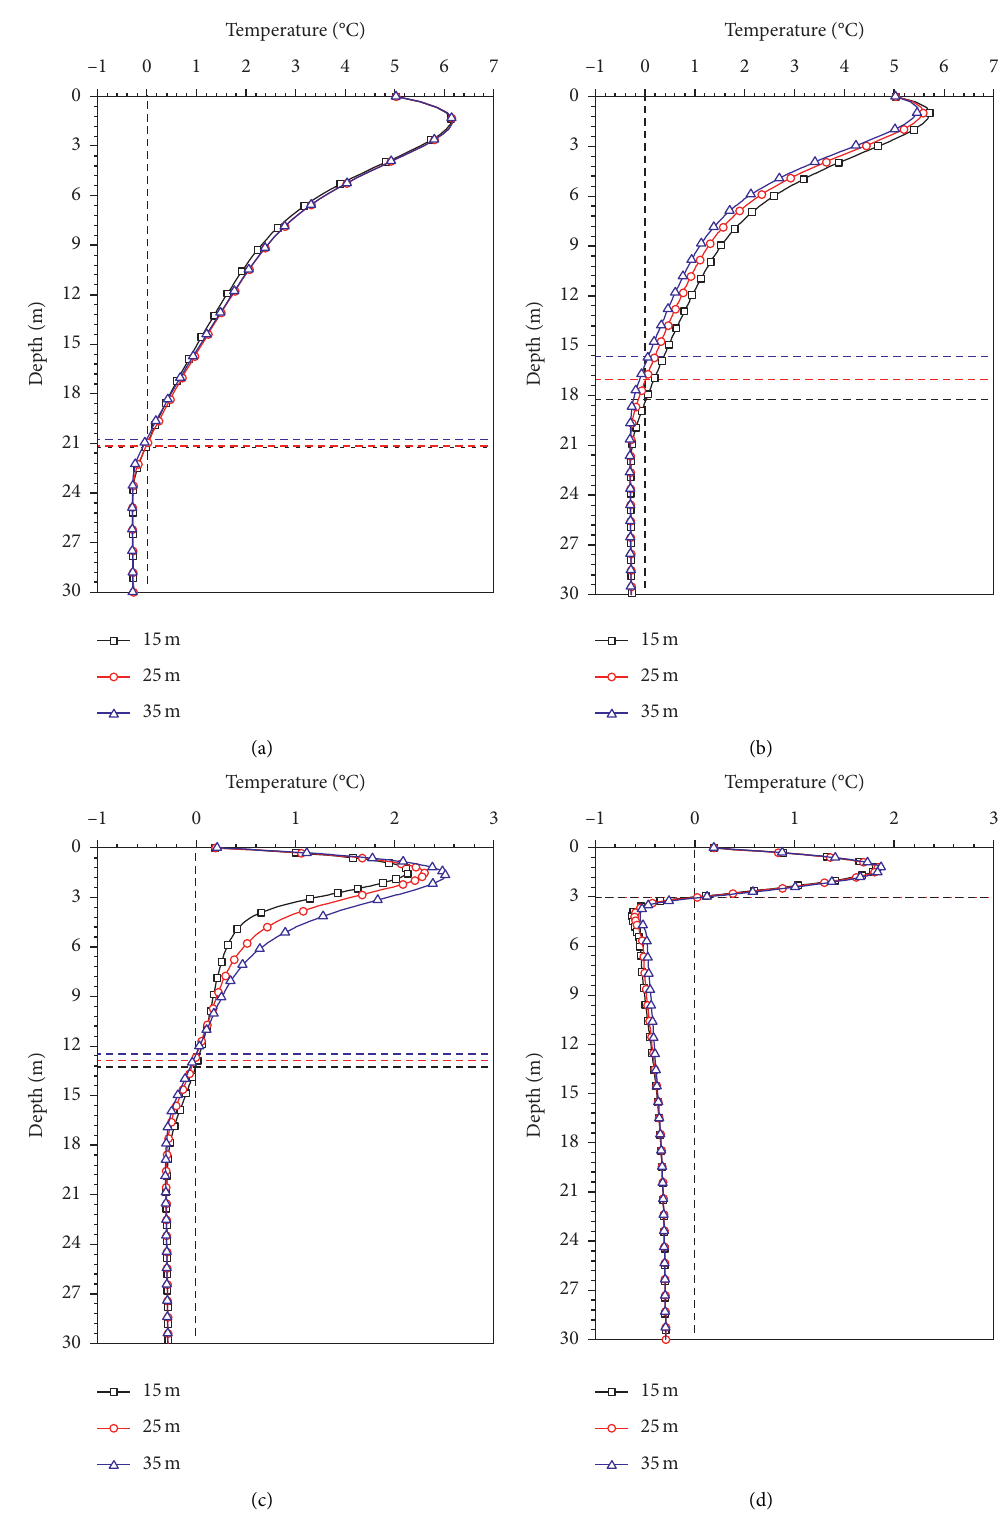
Figure 6: Ground temperature profiles at CC (a), ST (b), MS (c), and SS (d) of the channels with widths of 15, 25, and 35m on October 15 in the 10 th year after the channel